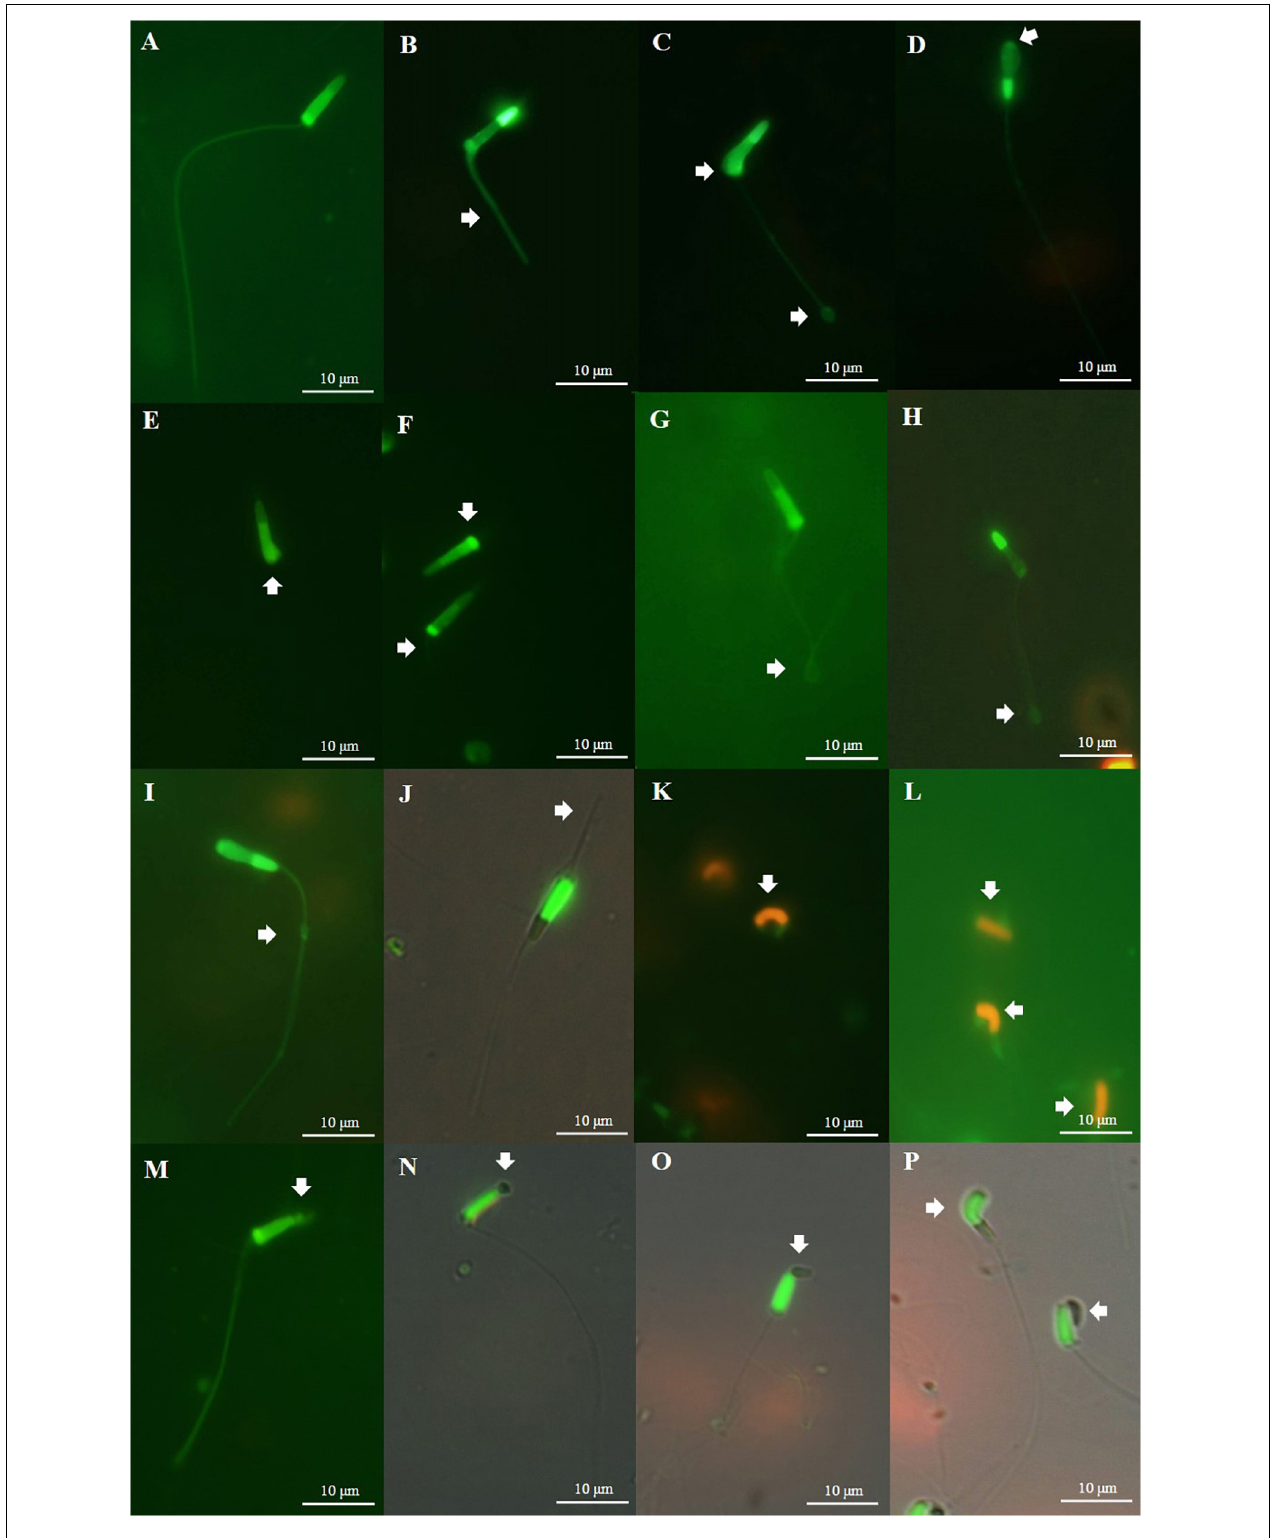
FIGURE 6 | Defects of Pacific abalone sperm cryopreserved with different types of cryoprotectants (8% Me 2 SO, 2% GLY, 8% EG, 6% PG, and 2% MeOH). (A) Normal shaped sperm; (B) short tail; (C) folding body and coiled tail; (D) neck folding; (E,F) detached head; (G) bent coil tail; (H) coiled tail; (I) droplet in tail; (J) broken tail; (K,L) total structure damage; (M–O) acrosome defect; and (P) acrosome defect and folding body.